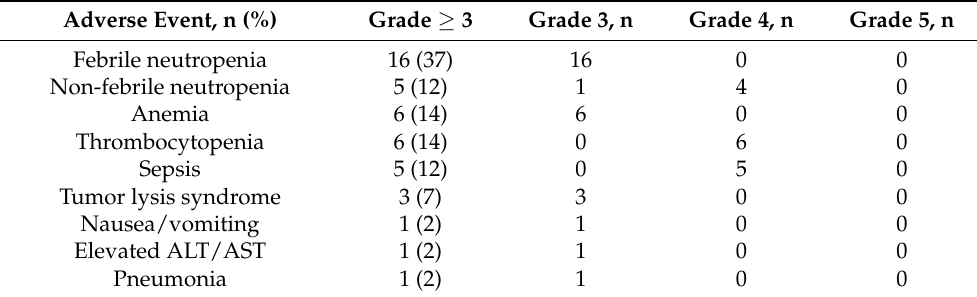
Table 3. Adverse events attributable to venetoclax per CTCAE v5.0